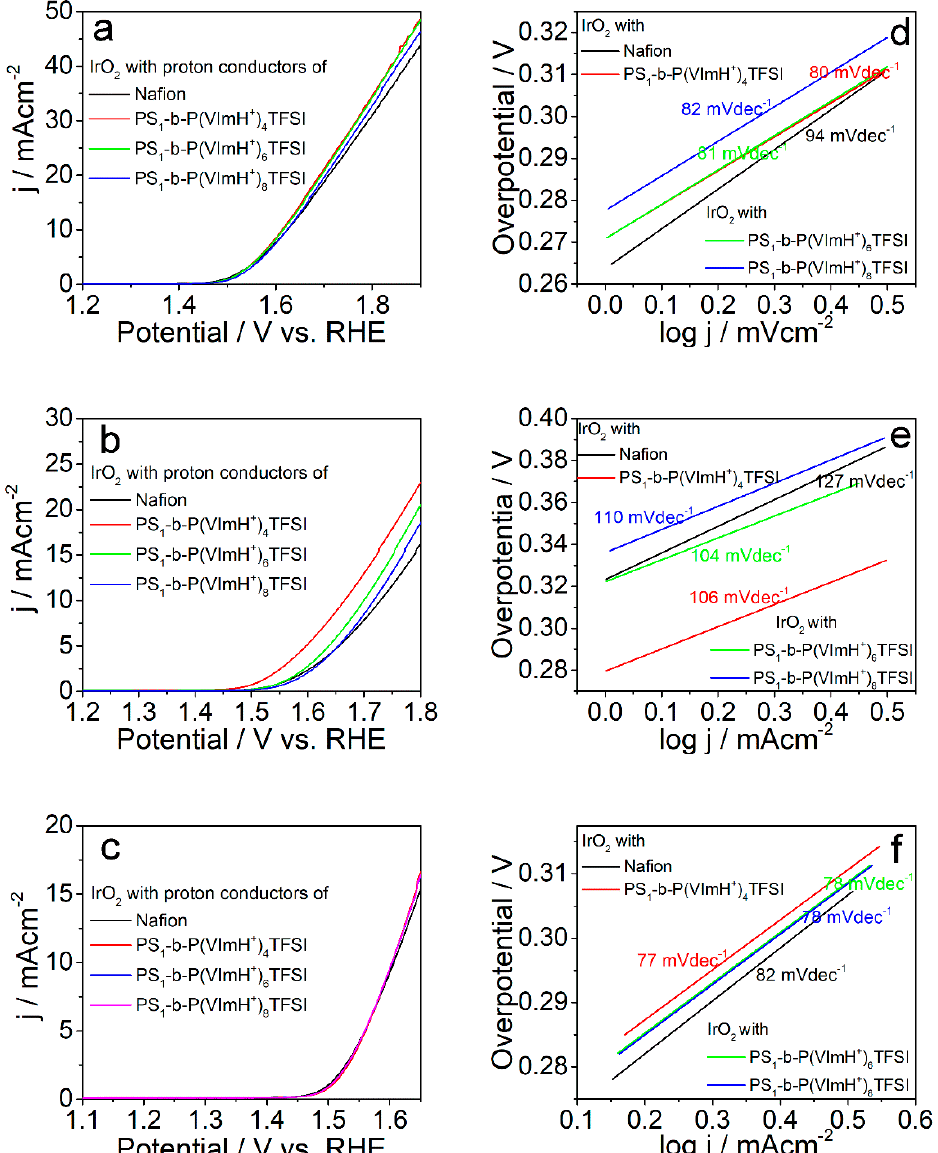
Figure 4. ( a – c ) Linear sweep voltammetry (LSV) curves and ( d – f ) Tafel plots of IrO 2 catalyst using different ionic conductors, as indicated in the figures with a sweep rate of 5 mVs − 1 in ( a , d ) 1.0 M KOH, ( b , e ) PBS buffer, and ( c , f ) 1.0 M HClO 4 .